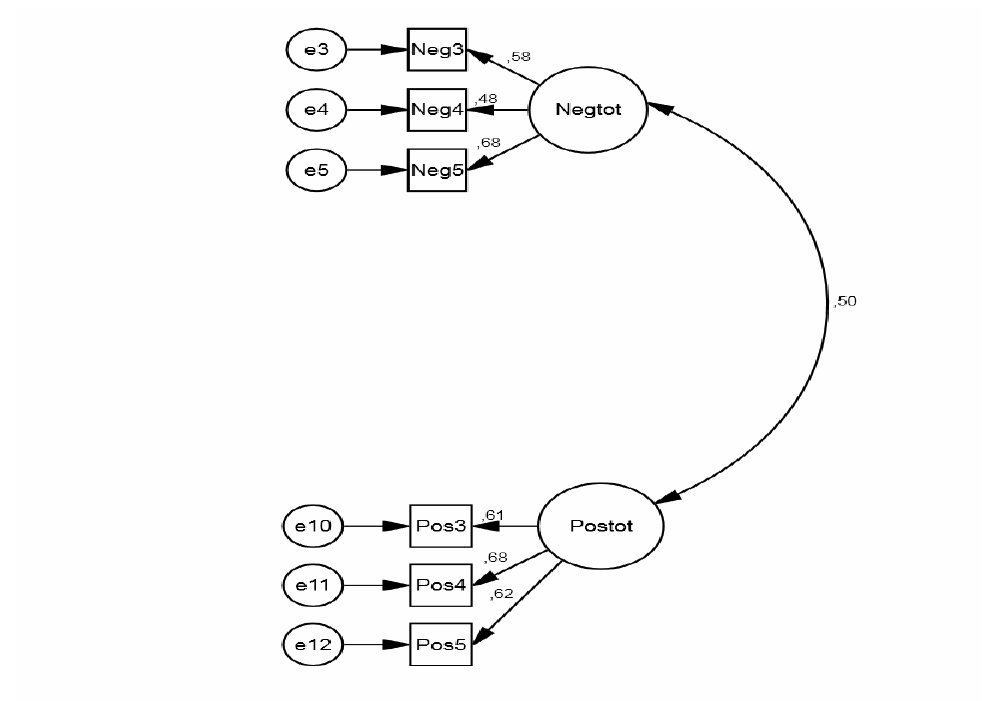
Figura 4. Versão reduzida da medida de ERP – per fi l de regulação